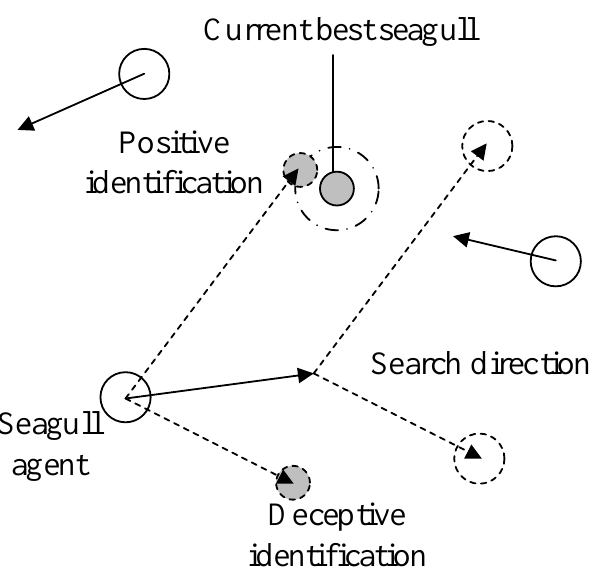
Figure 3. Schematic diagram of a seagull agent approaching the current optimal individual.